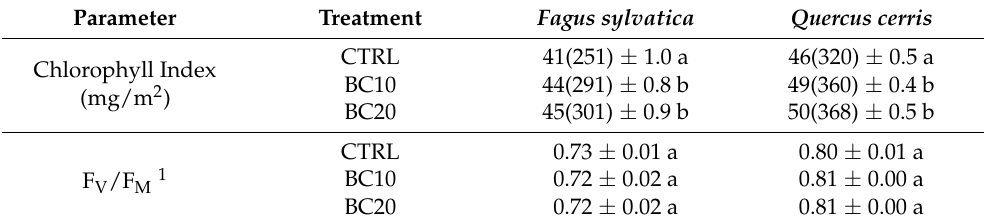
Table 2. Expression of the physiological parameters (mean ± standard error) for plants of Fagus sylvatica and Quercus cerris grown in soils amended with 0% (CTRL), 10% (BC10), and 20% (BC20) of BC; for each species, different letters indicate statistically significant differences between treatments ( p <